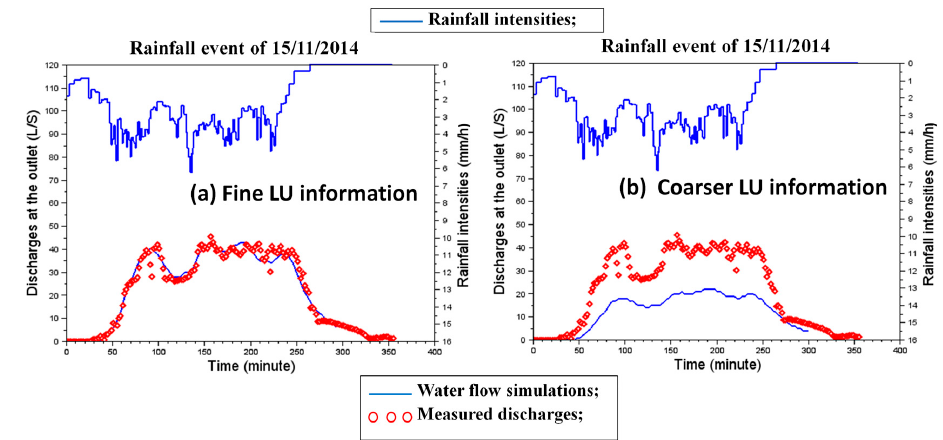
Figure 11. Hydrogram at the outlet of catchment using different land use (LU) input maps. For ( a ) LU input map (5 m) converted from fine LU information; ( b ) LU input map (5 m) converted from coarser LU information. The simulated discharges at the outlet (solid blue line) are compared with the measured data (red circles). Rainfall is plotted on the upper part. Table 8. Influence of fine land use (LU) information on water flow at the outlet of the sewer system.